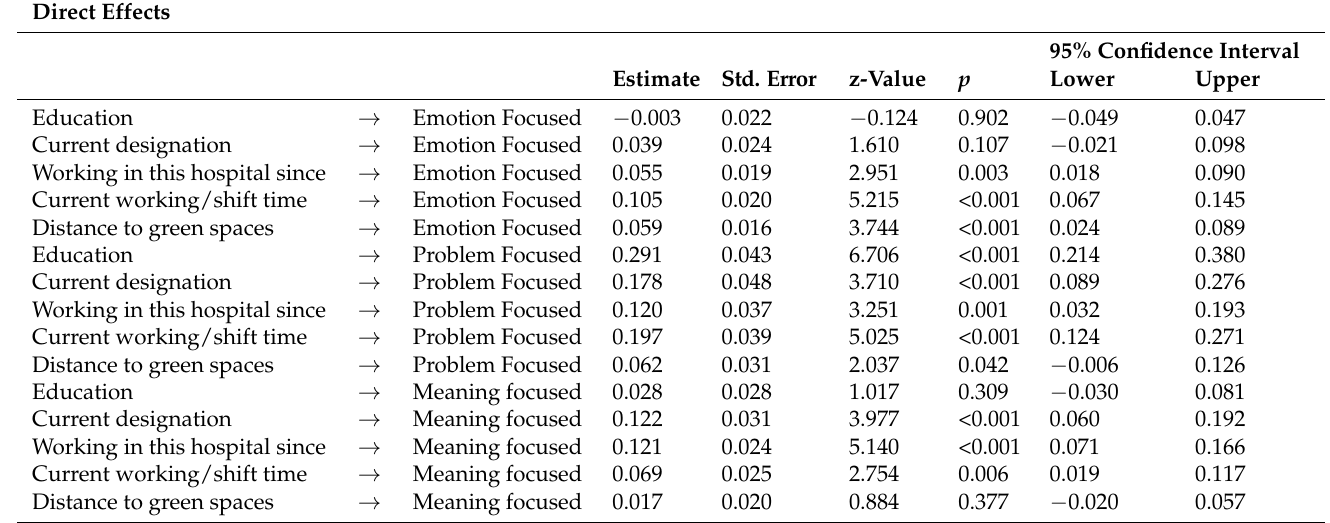
Table 1. Direct effects of demographics on challenges and coping